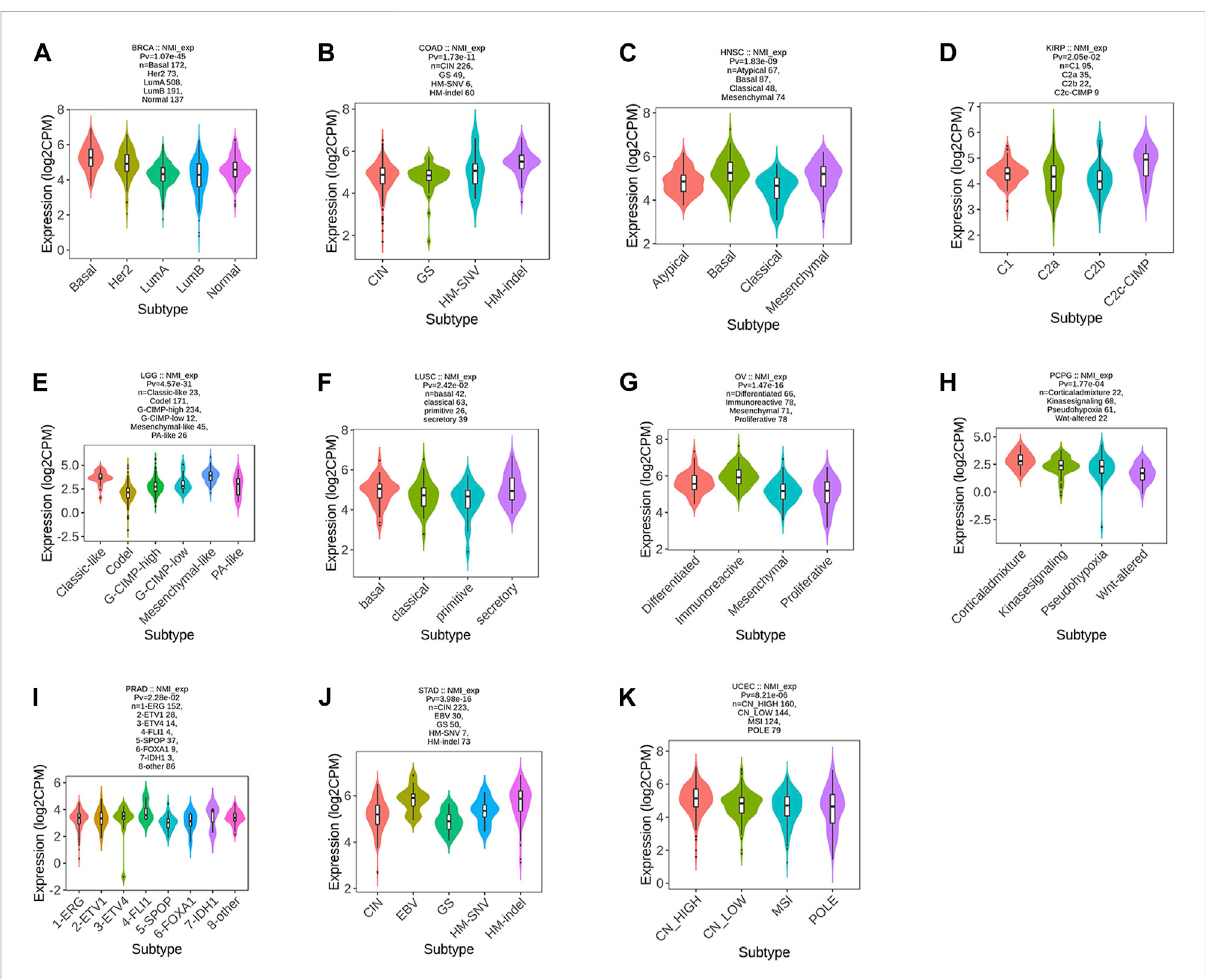
FIGURE 2 CorrelationanalysisbetweenNMIexpressionandtumormolecularsubtypes. (A) BRCA, (B) COAD, (C) HNSC, (D) KIRP, (E) LGG, (F) LUSC, (G) OV, (H) PCPG, (I) PRAD, (J) STAD, and (K)